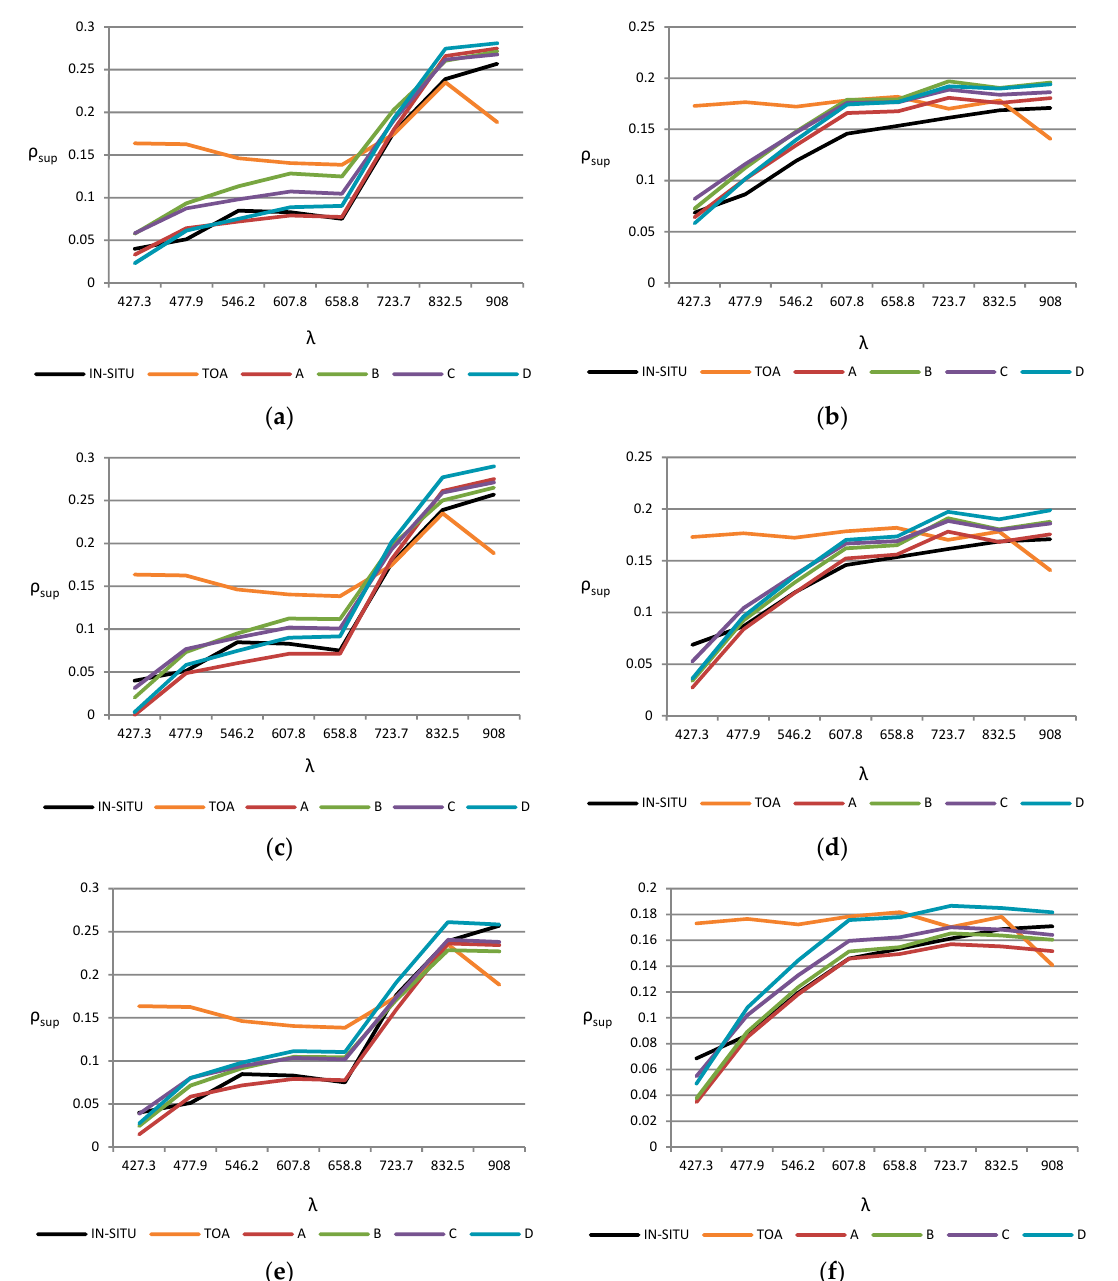
Figure 7. Spectral reflectivity signatures applying different atmospheric inputs for the following methods: ( a ) FLAASH at a vegetation point; ( b ) FLAASH at a bare soil point; ( c ) ATCOR at a vegetation point; ( d ) ATCOR at a bare soil point; ( e ) 6S at a vegetation point; ( f ) 6S at a bare soil point.